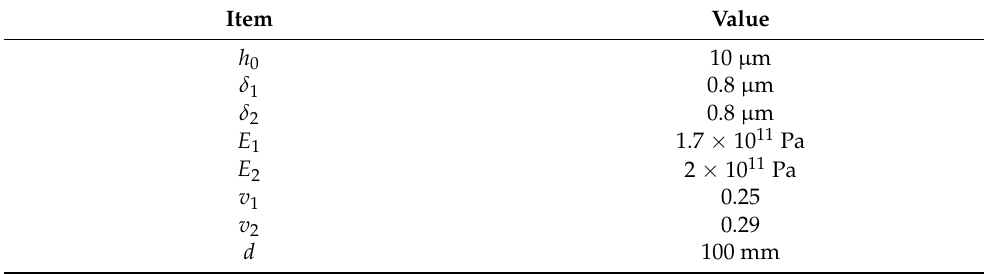
Table A1. The value of calculation